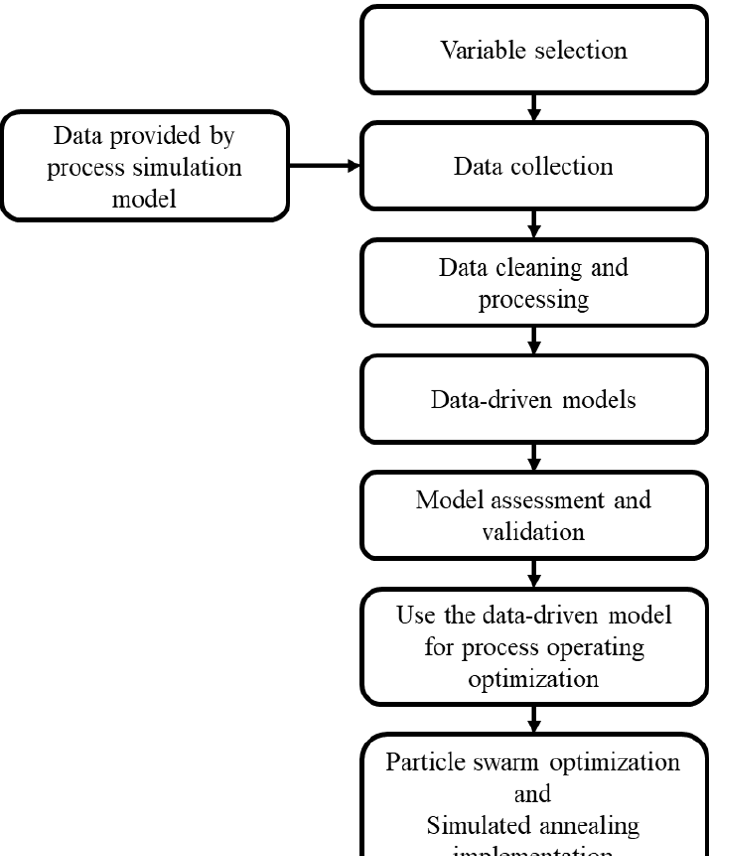
Figure 1. Workflow diagram of the proposed method for data-driven process modeling and